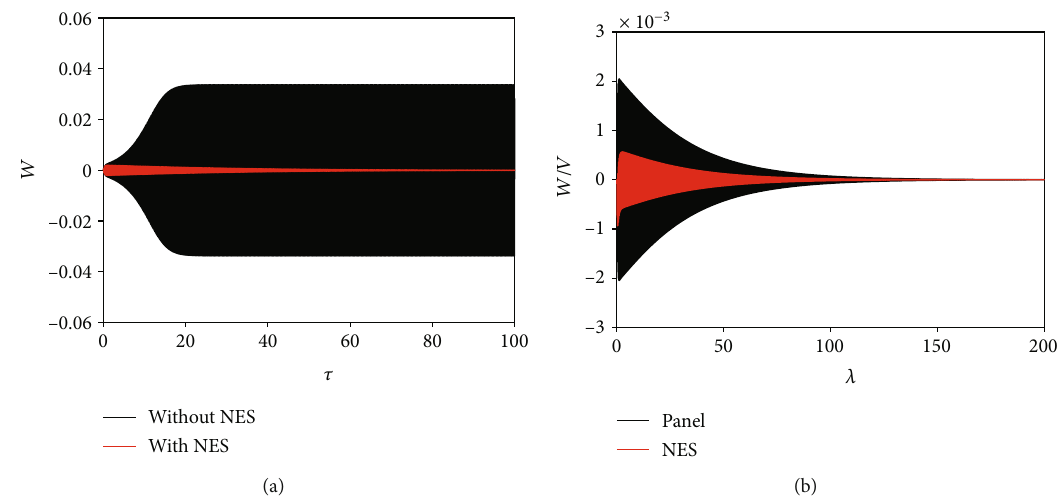
Figure 6: Time history at λ = 348 : (a) responses of the panel with and without an NES; (b) responses of the NES and